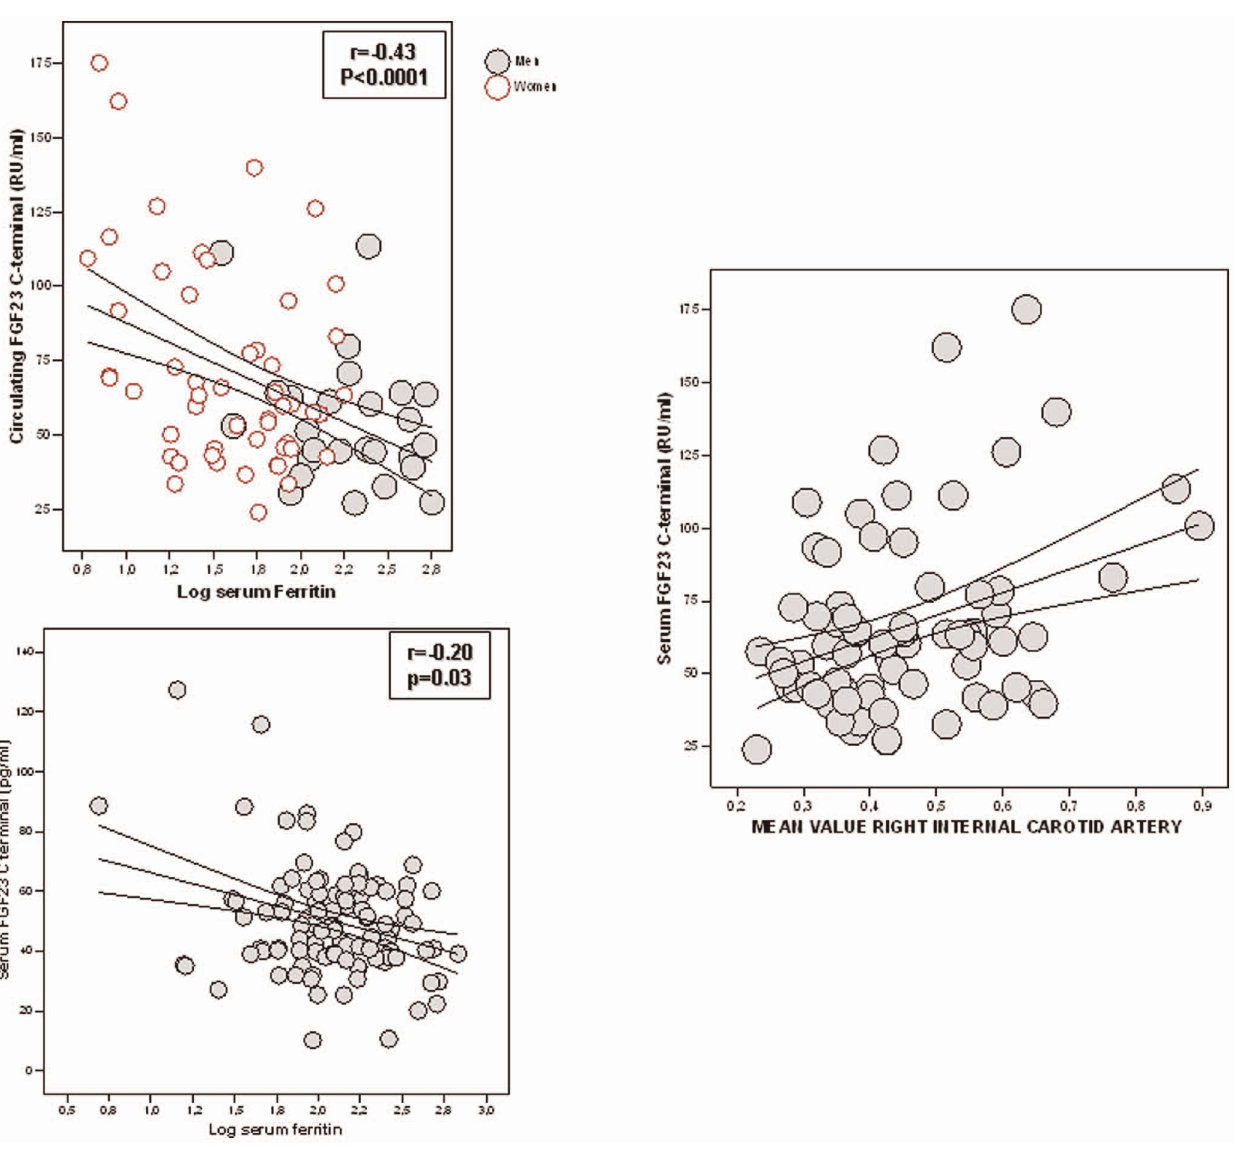
Figure 3. FGF-23 associations with ferritin and intima media thickness. Linear association analysis between serum C-terminal FGF-23 concentration and serum ferritin levels in Cohort 1 ( a ) and 2 ( b ); c) . Linear association analysis between serum C-terminal FGF-23 concentration and